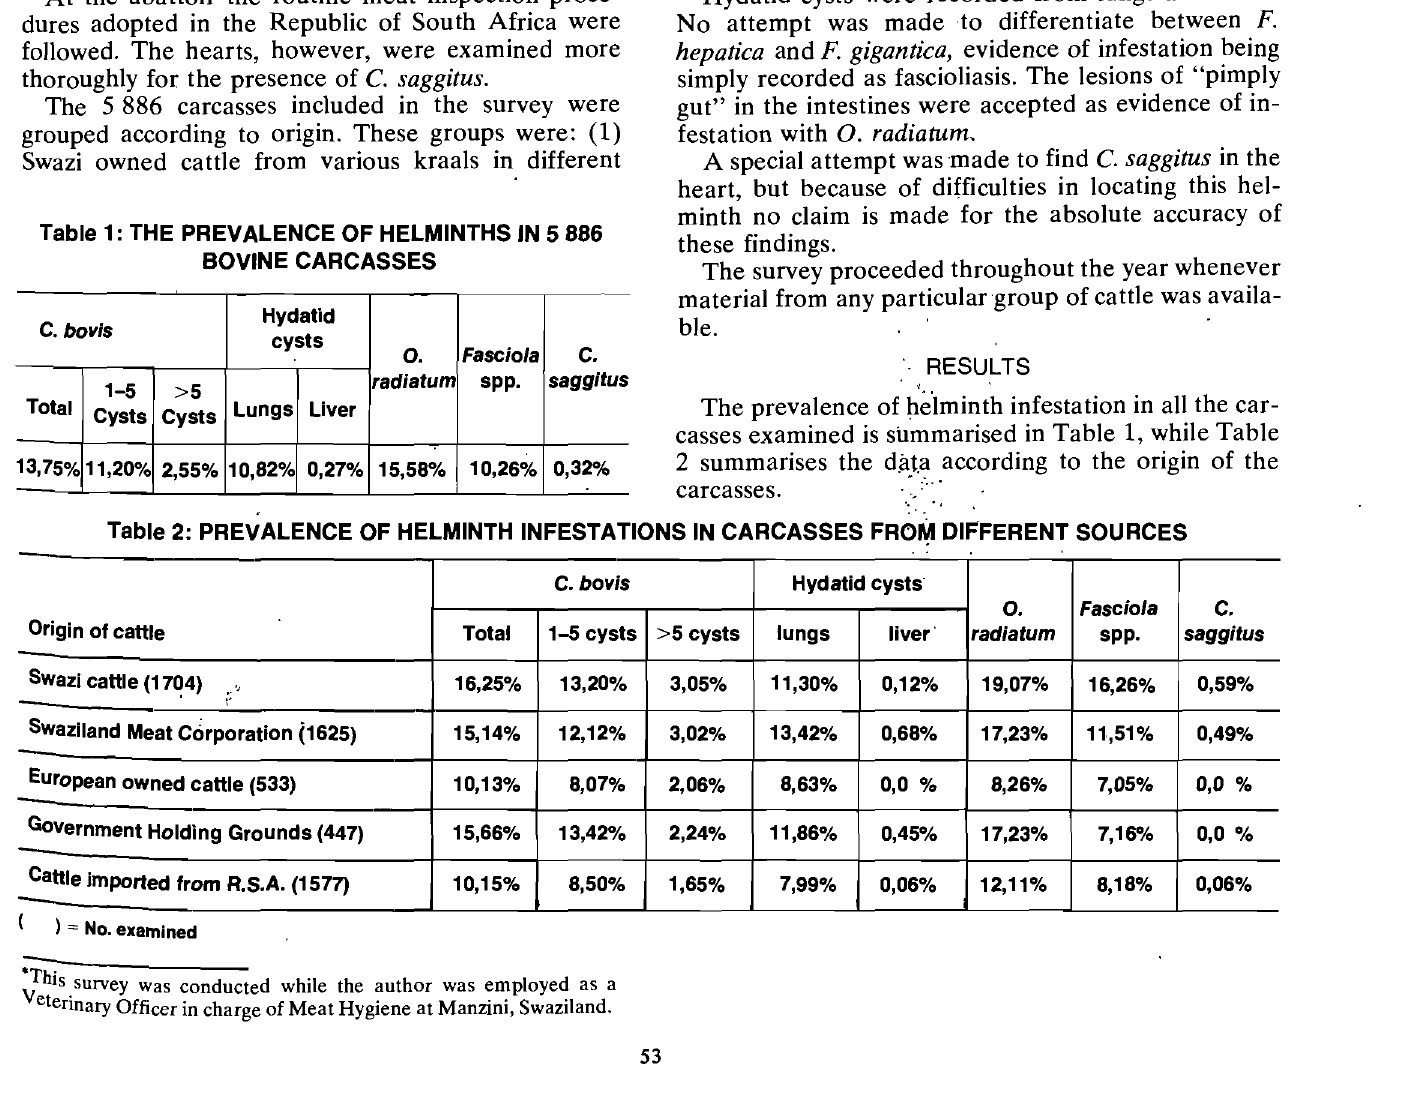
Table 2: PREVALENCE OF HELMINTH INFESTATIONS IN CARCASSES FRO~ DIFFERENT SOURCES